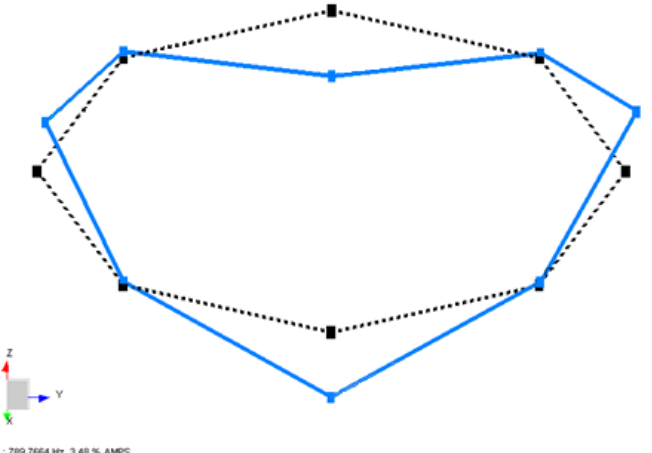
Figure 9. Drive point frequency response function (FRF) for Coil Type-1. The blue lines represent the deformed shape, while the black dashed lines represent the undeformed shape of the Coil Type-1 in Figures 10–12.